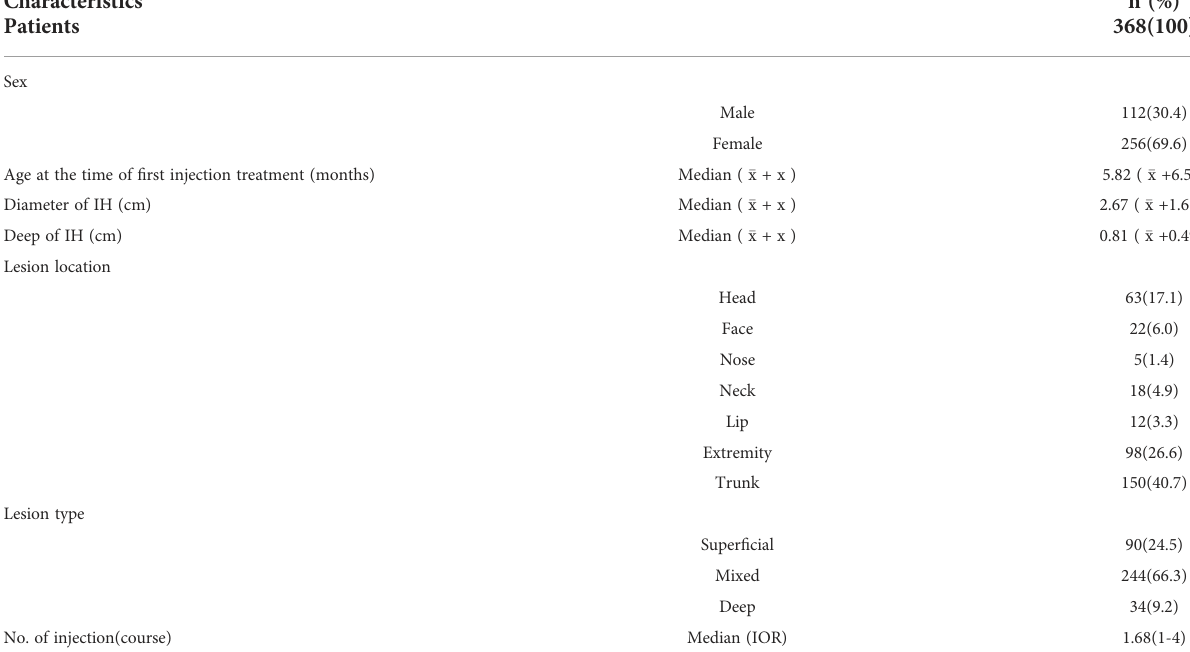
TABLE 1 Baseline characteristics of 368 infantile hemangiomas.